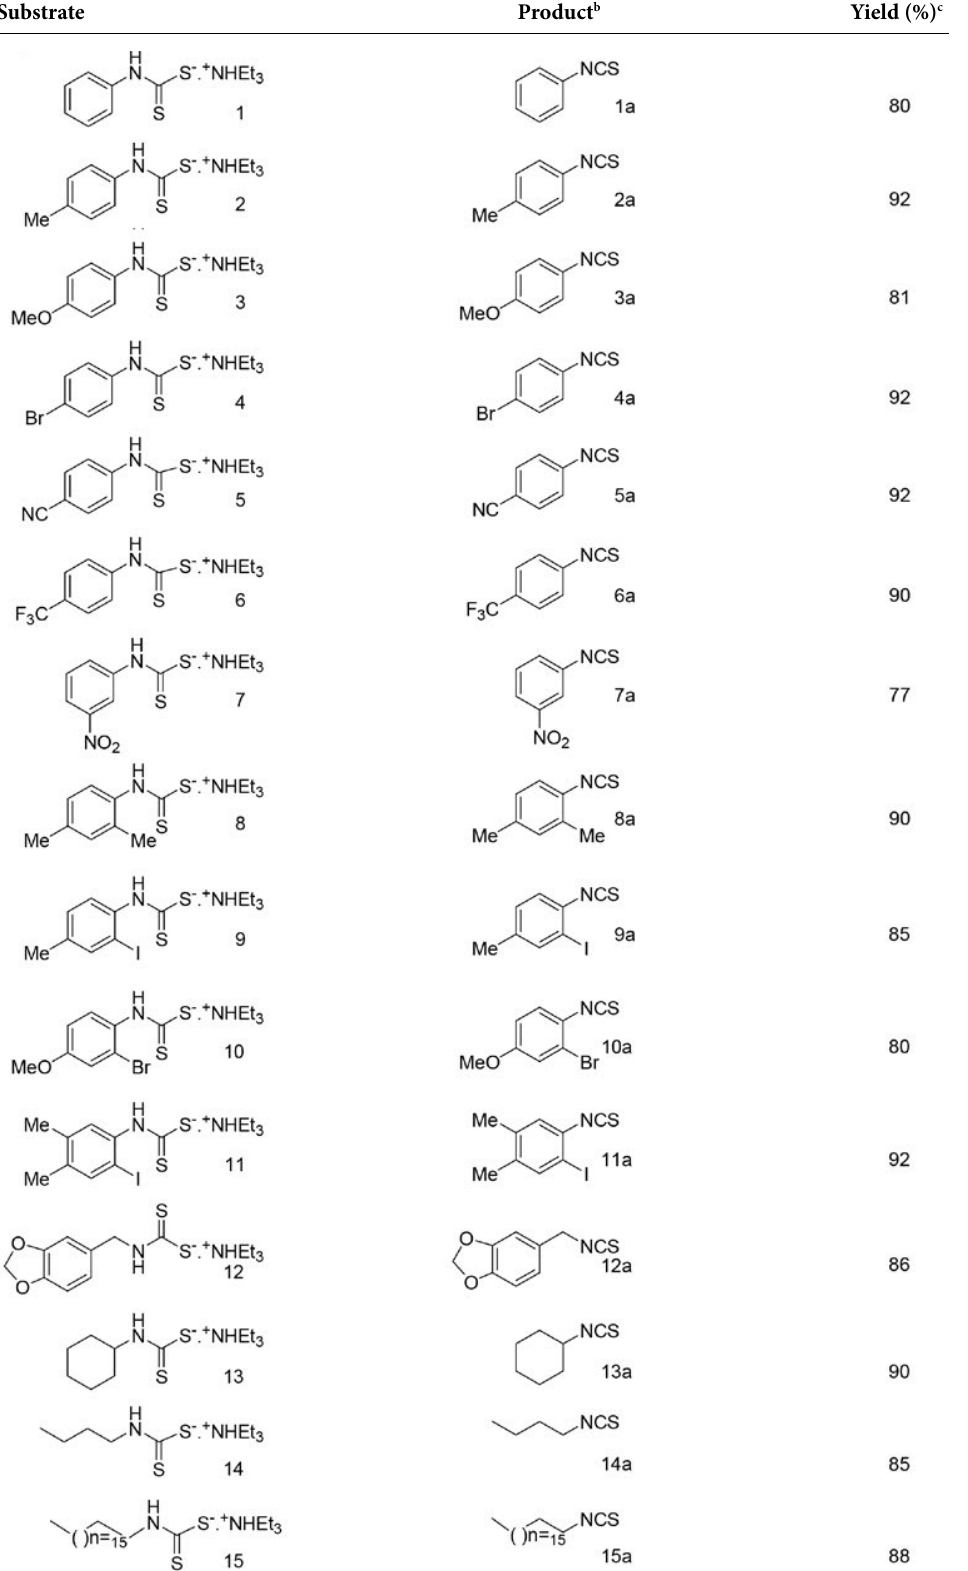
Table 1 . Preparation of Isothiocyanates from Dithiocarbamate Salt and TPATB a